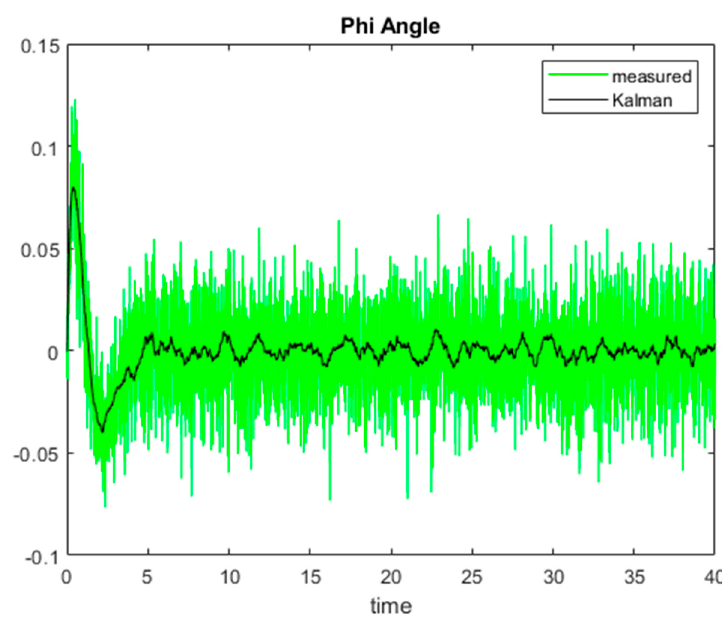
Figure 9. Phi angle measured and Kalman value.